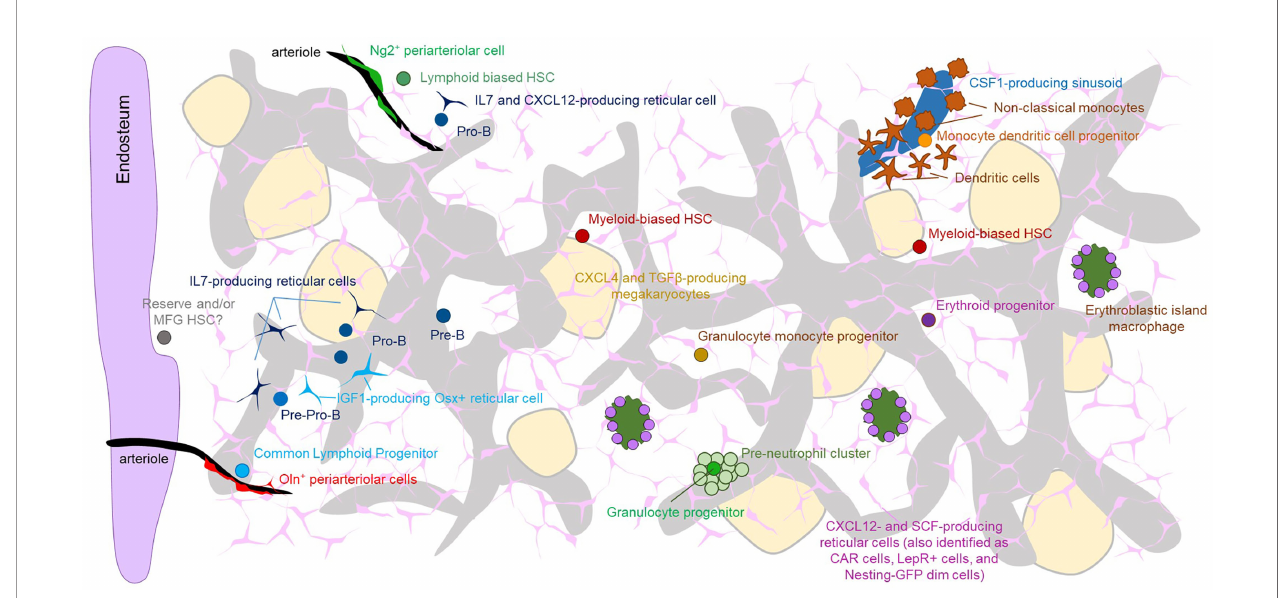
FIGURE 1 | The Figure shows the overall architecture of the microenvironment in the bone marrow as well and the localization of the indicated progenitors with speci fi c microenvironment. Note that because of the abundance of sinusoids and CXCL12- and SCF-producing perivascular cells virtually all cells are proximal to both of these structures. Also note that most types of stem cells and progenitors have been imaged with a limited number of partner cells. Therefore, it is likely that some of the structures depicted overlap (e.g. both erythroid progenitors and HSC have been shown to localize to SCF-producing perivascular cells). The precise location of most multi and oligopotent progenitors remains